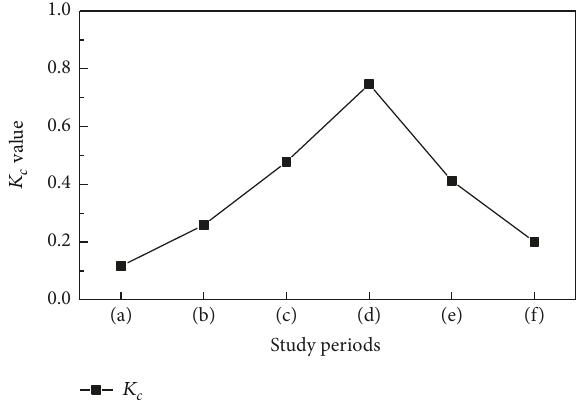
Figure 7: Variation of crop coefficient ( 𝐾 𝑐 ) at different study